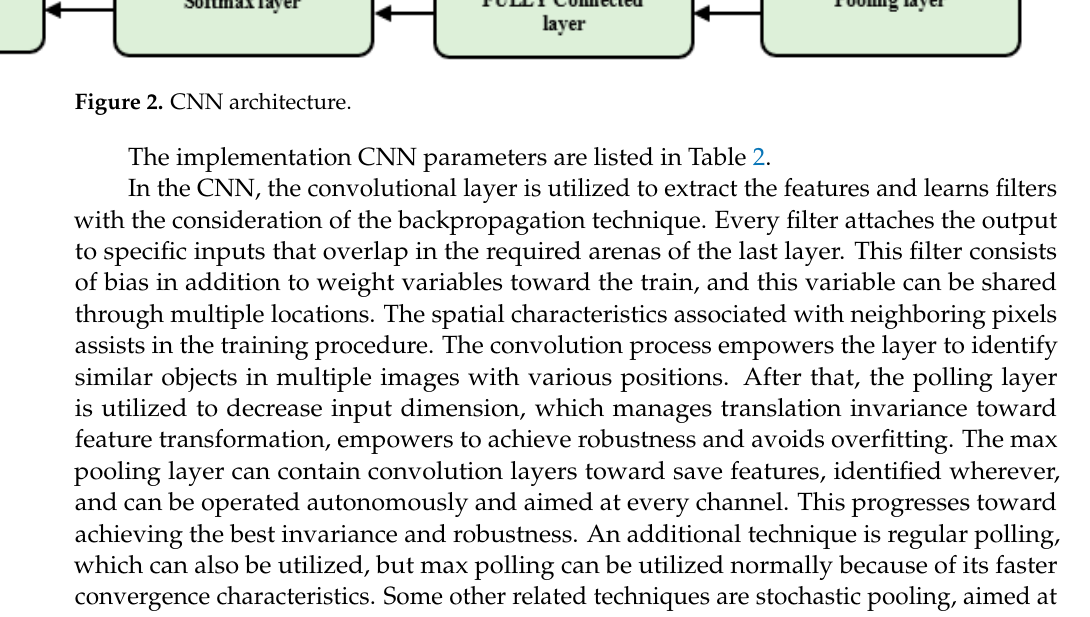
Figure 2. CNN architecture .